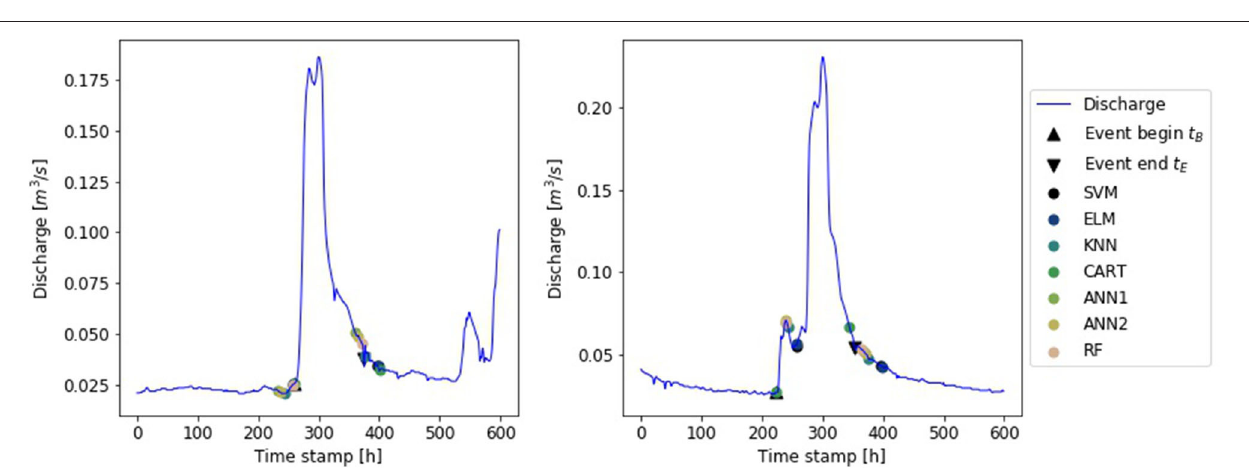
FIGURE 5 | Hydrographs for two flood events at gauge Lohr with manually and automated defined markers of event begin t B and end t E